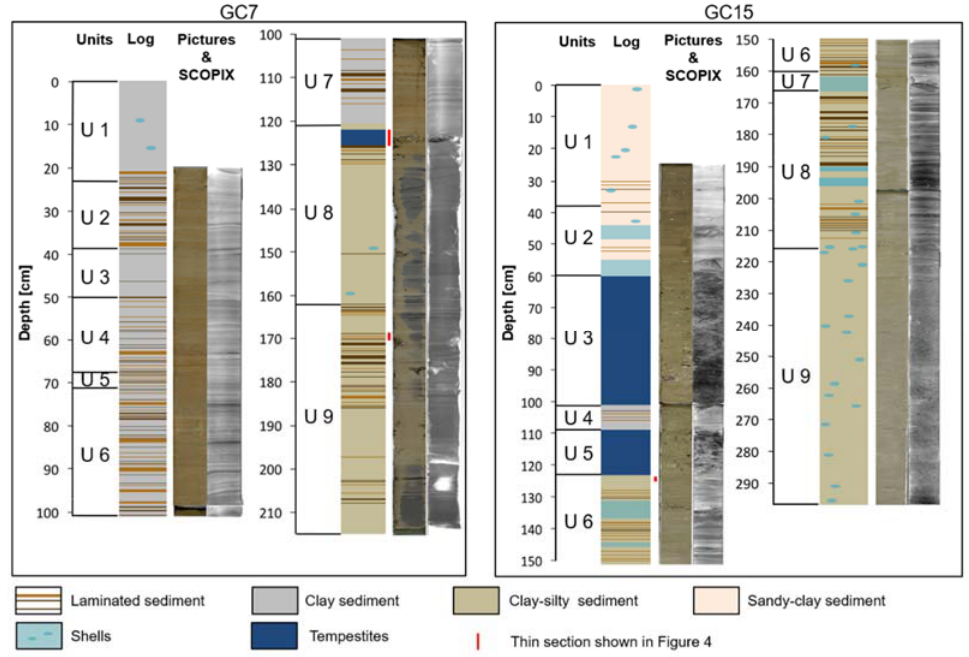
Figure 3. Lithological description with the pictures of the cores and the corresponding SCOPIX images. Nine lithological units were identified in GC7 and in GC15, according to macroscopic observations, SCOPIX and thin sections. For GC7, U1: Homogeneous clay sediment with a few whole shells (SCOPIX unavailable); U2: laminated (mm to pluri-cm) clay sediment; U3: homogeneous clay sediment; U4: laminated (mm to cm) clay sediment; U5: laminated (mm to cm) clay sediment; U6: clay sediment with laminations (mm to cm); U7: clay sediment with laminations (mm to cm) and a pluri-cm level without sedimentary structures; U8: clay-silty sediment with a tempestite (i.e. accumulation of whole shells and shell debris) at the top of the unit (this thin section shown in Figure 4), some laminations (mm to pluri-mm) and a pluri-cm level without sedimentary structure; U9: homogeneous clay-silty sediment with a few laminations (mm to cm). For GC15, U1: Sandy sediment with whole shells and rare laminations (pluri-mm to cm); U2: sandy sediment with a few laminations (pluri-mm), whole shells and shell debris; U3: amalgamated tempestites; U4: laminated (pluri-mm) clay sediment; U5: tempestite; U6: clay-silty sediment with laminations (mm to cm) and some whole shell and shell debris; U7: sediment with whole shells and laminations (mm to pluri-mm); U8: clay-silty sediment with laminations (mm to cm) and some whole shells and shell debris; U9: homogeneous clay-silty sediment with some whole shells and shell debris (not studied in